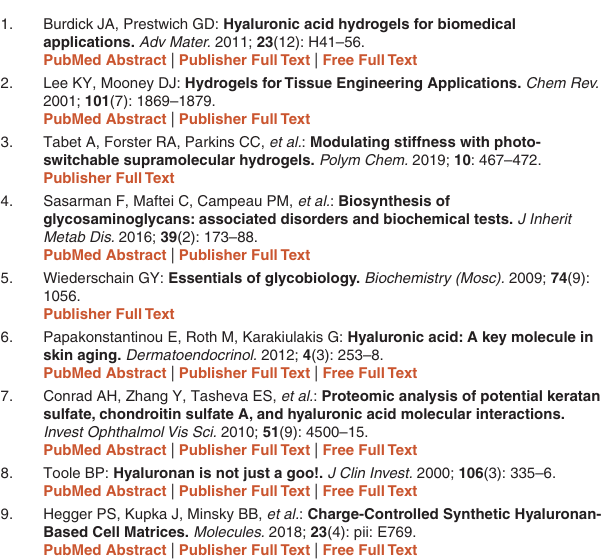
Data availability Underlying data for this study is available from Open Science Framework OSF: Dataset 1: Protein-mediated gelation and nanoscale assembly of unfunctionalized hyaluronic acid and chondroitin sulfate, https://doi.org/10.17605/OSF.IO/3BXQG 20